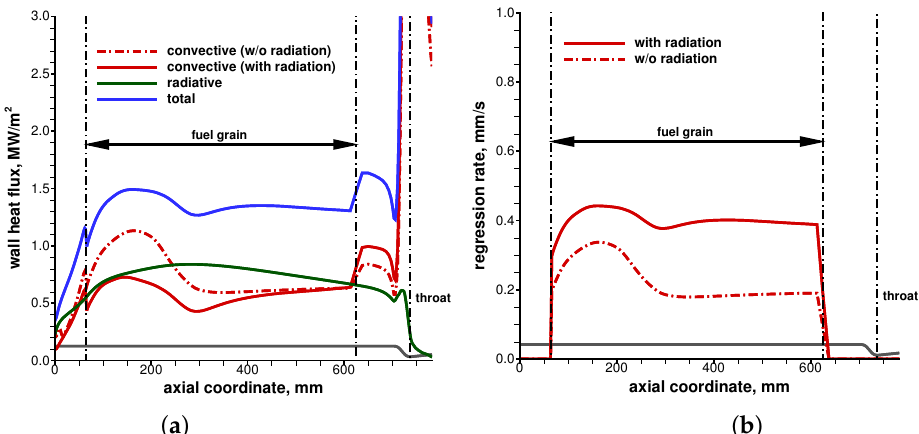
Figure 10. Axial distributions (with and without radiative energy exchange) of surface parameters for Firing Test #13: ( a ) convective and radiative heat flux; ( b ) regression rate.